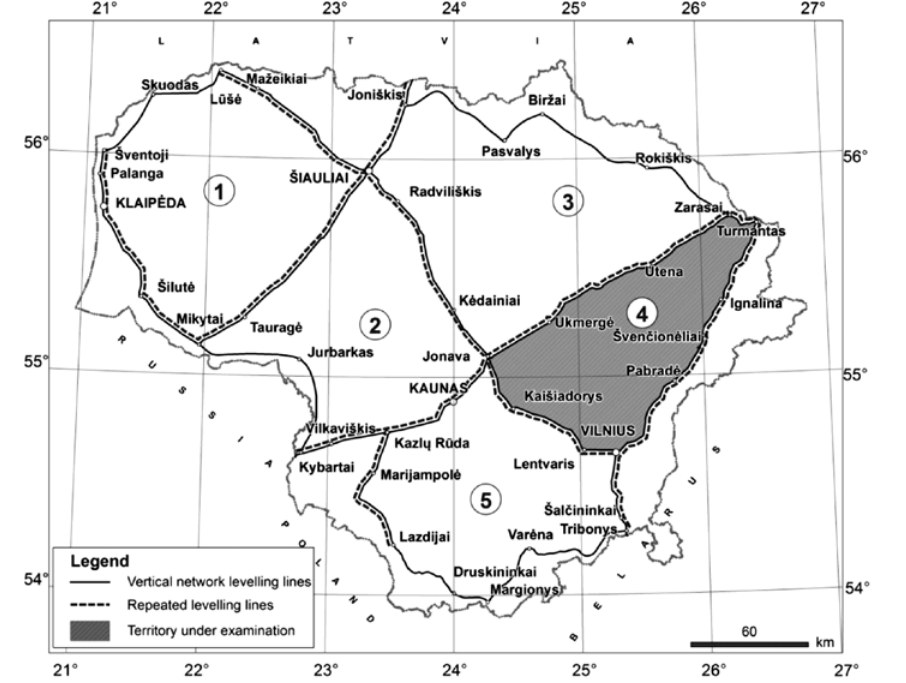
Fig. 1. Accuracy class I network created for the territory of Lithuania over 1998–2006 (with polygons marked on